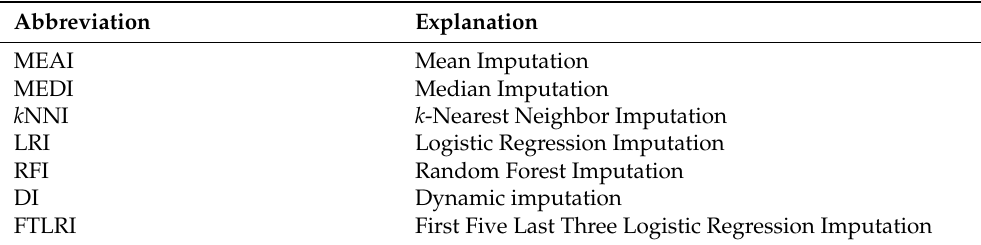
Table 4. Abbreviations and their explanations about imputation methods.